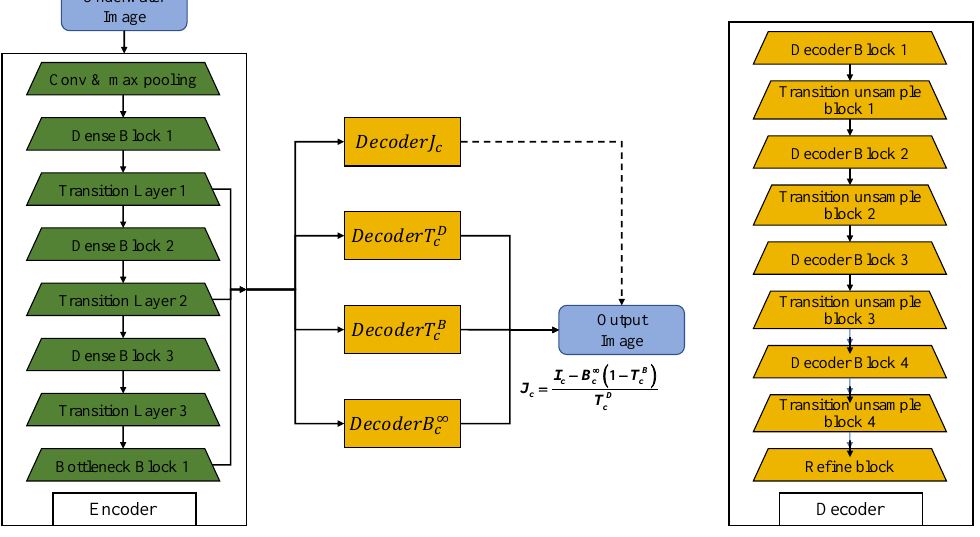
Figure 2. Estimation network